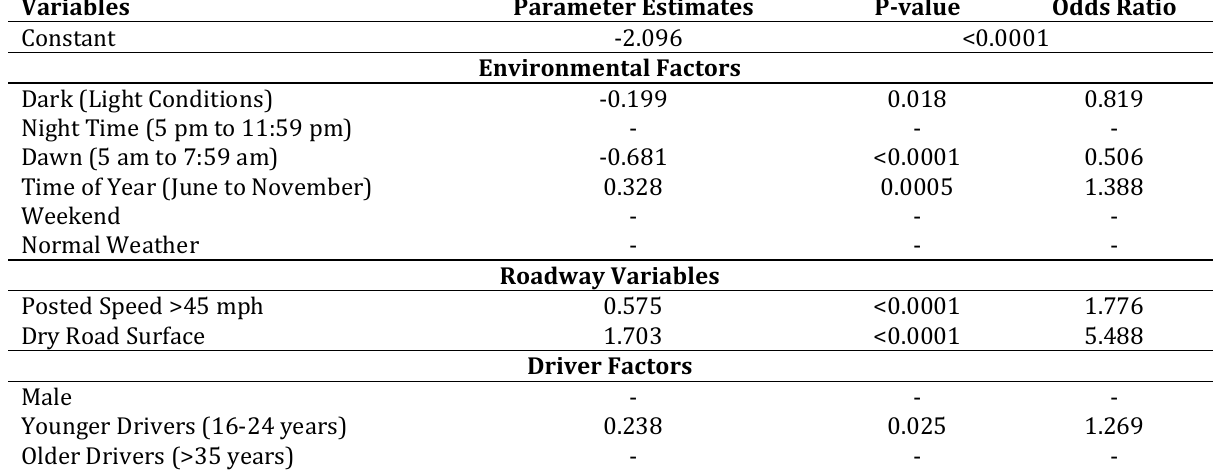
Table 1: Results of logistic regression model: